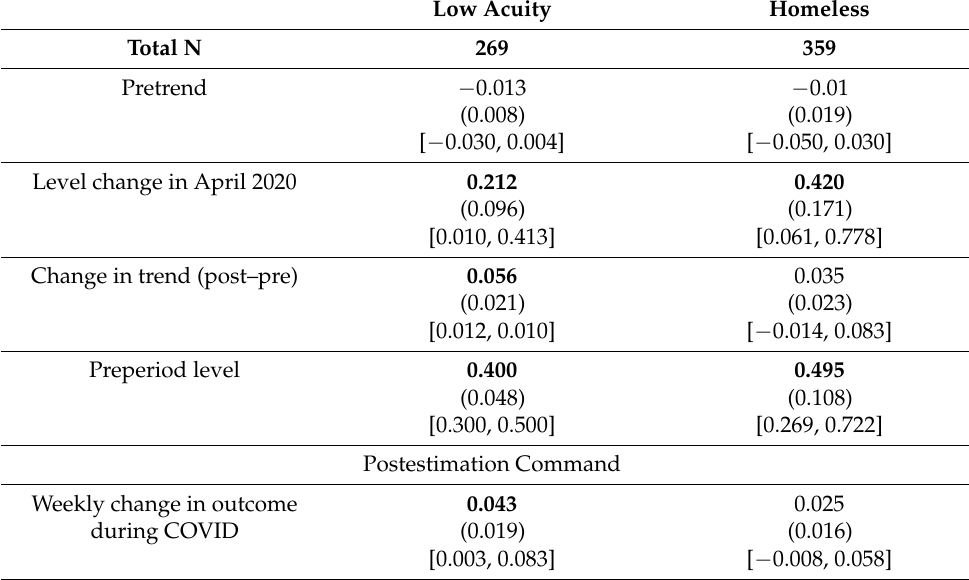
Figure A2. ITS Patient Visits by Payor Group. Table A1. OUD-Related ED Visit Characteristics by Race/Ethnicity: Black Patients.